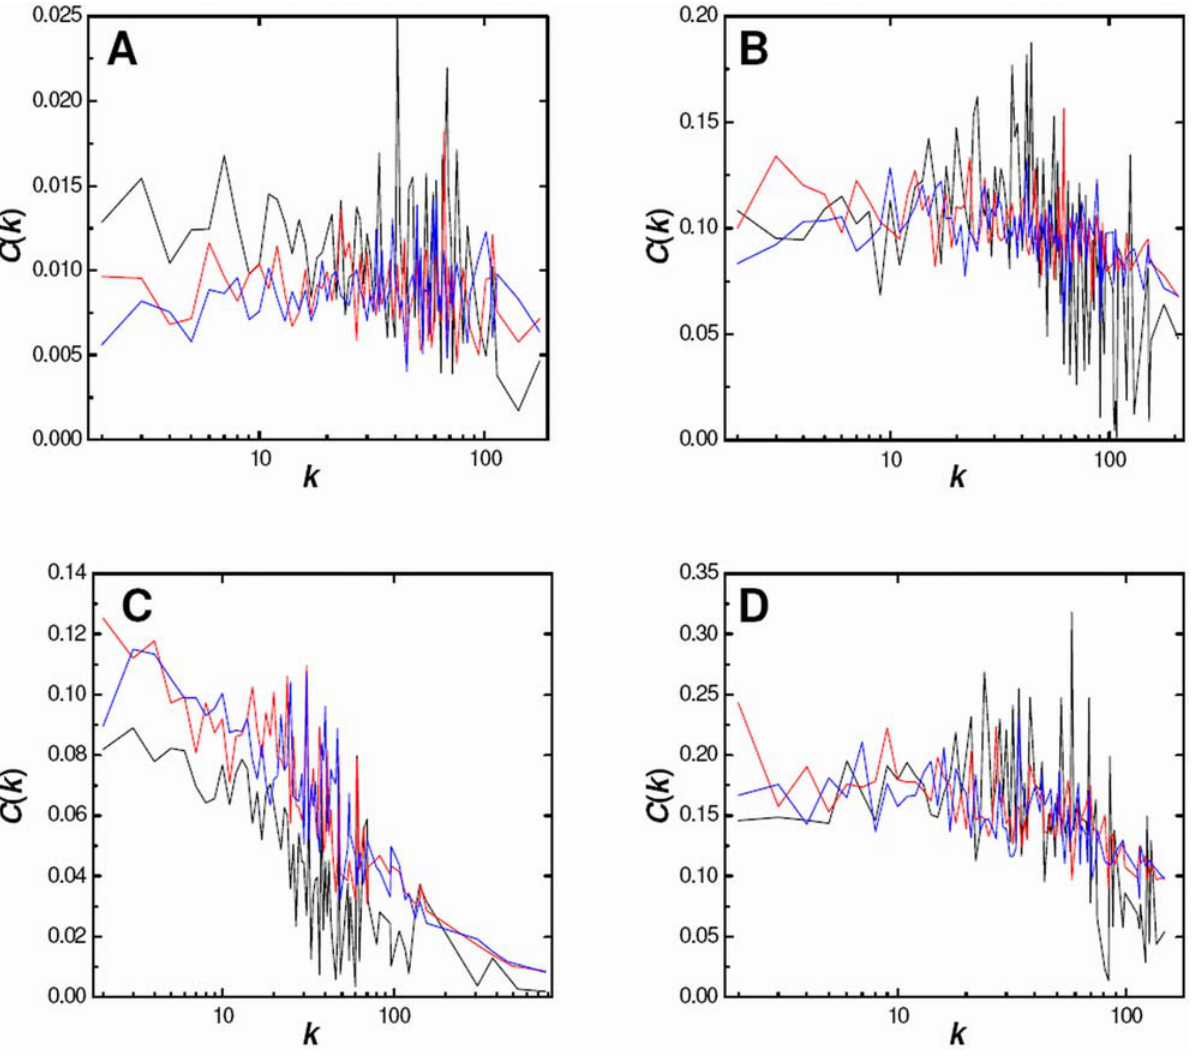
Figure 4. Dependence of Clustering Coefficient upon Node Degree for Four PPI Networks and their DCDW Equivalents. (A) Drosophila melanogaster , (B) Campylobacter jejuni , (C) Escherichia coli ( HT2 ), and (D) Escherichia coli ( HT1 ). Clustering profiles for the PPI networks (black) and the corresponding tenth (blue) and fiftieth (red) realizations of the DCDW model.